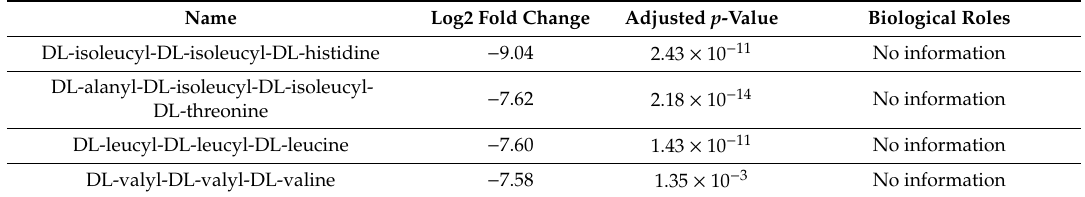
Table 2. Biological roles of the top 10 differentially expressed molecules in “aszú” and the top 10 differentially expressed molecules in “furmint” wines. The name, log2 fold change, adjusted p -value and the biological role is indicated in case of each compound. Negative fold change represents significantly higher level in “furmint”, while positive fold change shows significantly higher level in “aszú”.